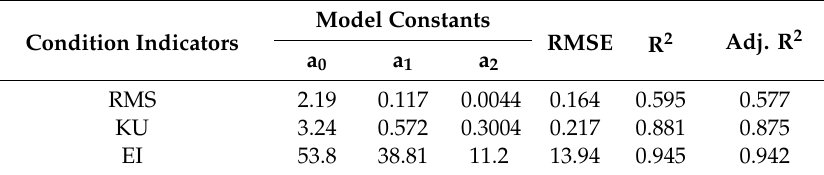
Table 3. General optimal estimated polynomial model